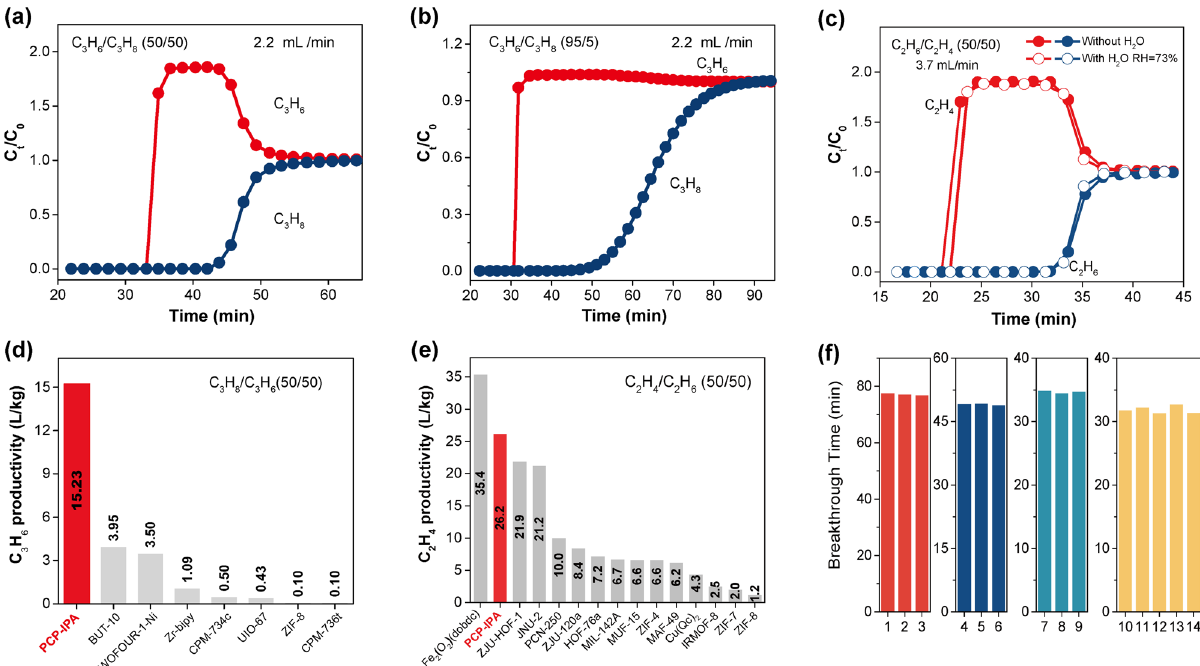
Fig.4|Paraf fi n/ole fi nseparation. Dynamicbreakthroughcurvesunder298Kand 1.0bar of a C 3 H 8 /C 3 H 6 (50/50 v/v ) mixture, b C 3 H 8 /C 3 H 6 (5/95 v/v ) mixture, and c C 2 H 6 /C 2 H 4 (50/50 v/v )with(hollow)orwithoutwatervapor(solid);comparisonof high pure ole fi n productivity on PCP-IPA with reported benchmark materials